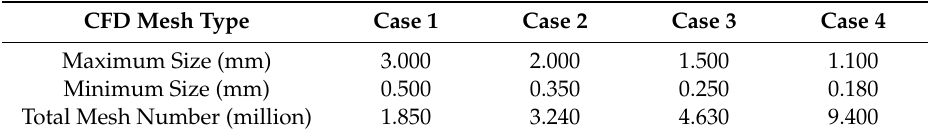
Table 2. Mesh size of blade surface.